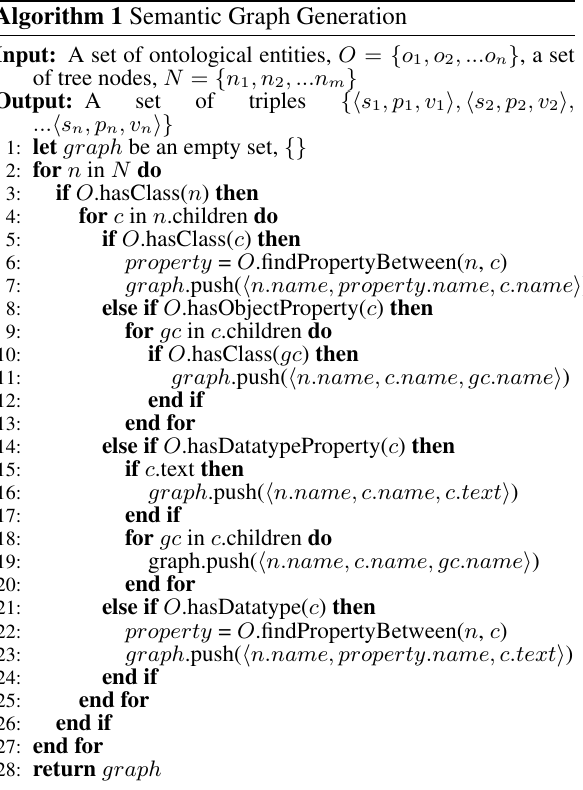
Algorithm 1 Semantic Graph Generation